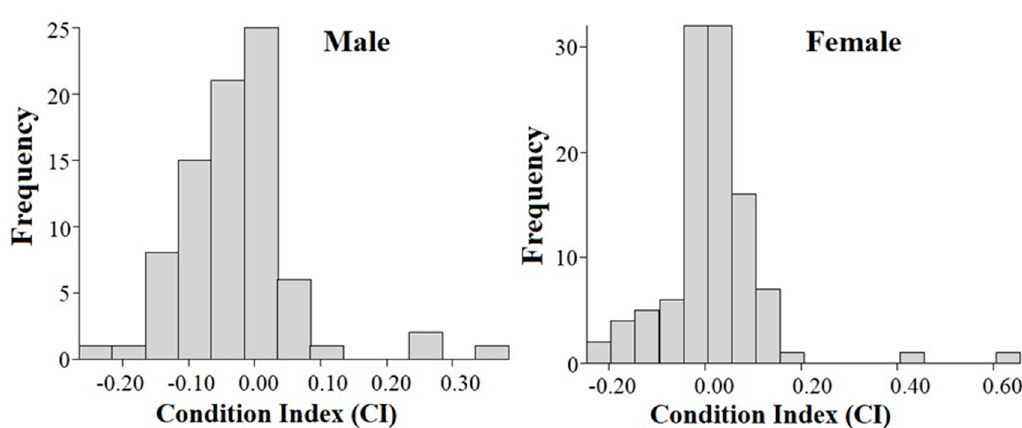
Figure 3. Frequency distributions of body condition index (CI) in male ( n = 81) and female ( n = 107) Hermann’s tortoises in Albania.